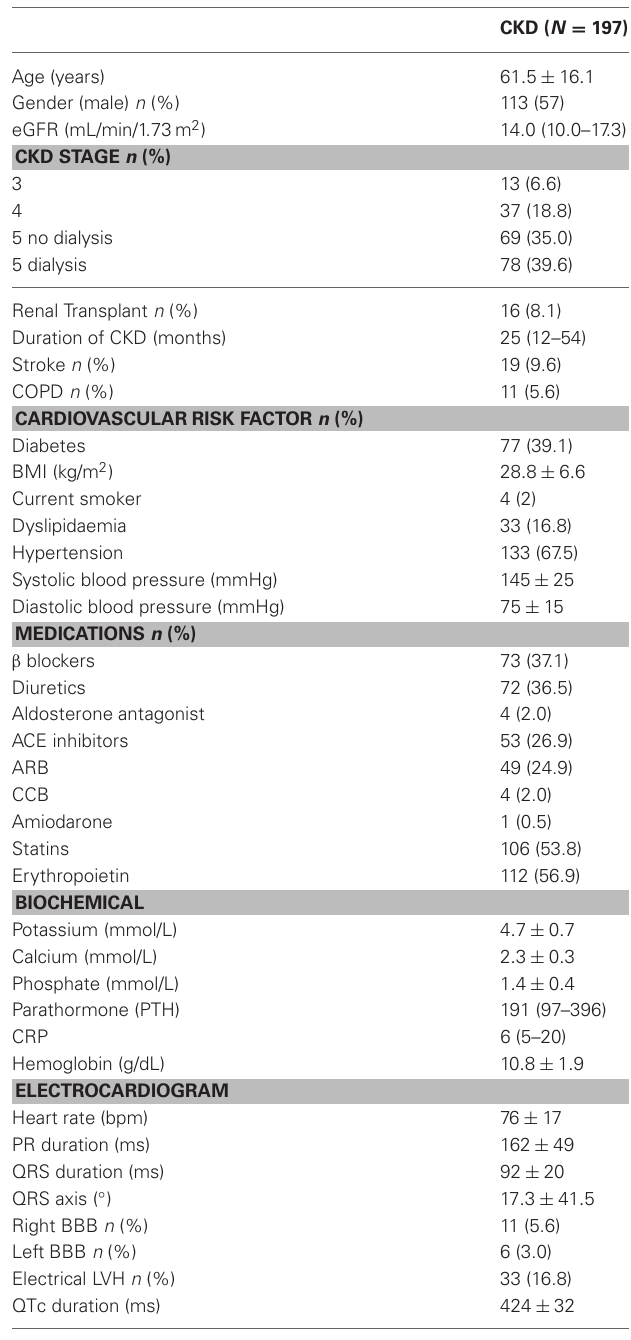
Table 1 | Baseline characteristics of patients with